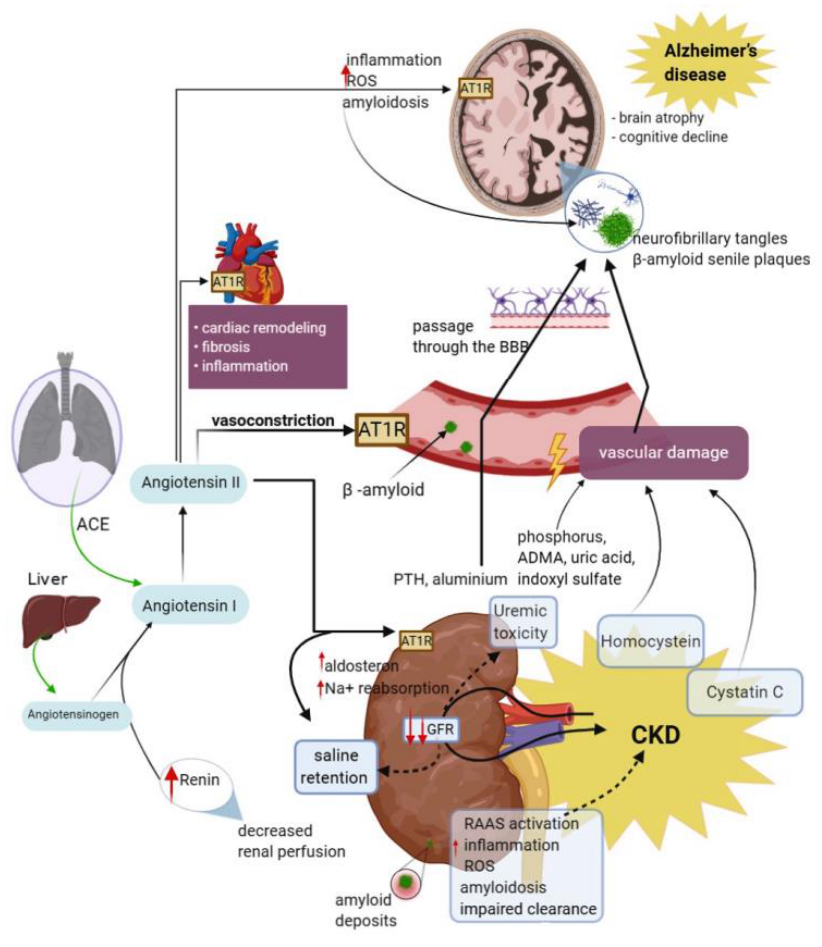
Figure 2. Schematic representation of mechanisms implicated in cognitive decline and AD in CKD patients, comprising renin–angiotensin system, oxidative stress, vascular injury, and inflammation. Diminished glomerular filtration rate and renal perfusion affect renal clearance. Renal retention of oxidizing substances promotes the intensification of oxidative stress and inflammation, which together with a defective clearance, causes an increase in plasma concentrations of uremic toxins, homocysteine, Cystatin C, amyloid deposits, and other molecules. These substances exert their toxic action through various mechanisms. Low renal perfusion leads to increased renin synthesis, and in its presence, the angiotensinogen synthesized in the liver is transformed into angiotensin I, which in turn, in the presence of angiotensin converting enzyme passes into angiotensin II. Angiotensin II activates AT1 receptors and produces hydro-saline retention, cardiac remodeling, vasoconstriction, and the development of β-amyloid deposits. The consequences of kidney damage are also reflected in the vascular and cerebral level with the aggravation of the cognitive deficit present in AD. The potential mechanisms of kidney–brain crosstalk regarding inflammatory molecules are because cytokines frequently involved in the pathogenesis of CKD may influence remote organs, such as the brain. The pathogenesis of the oxidative stress in patients with CKD is exhaustive, uremia and dialysis being among the important and frequent factors. Moreover, in these patients, an excessive increase in ROS was linked to the inflammatory processes, as the presence of endogenous oxidants and uremic toxins in the plasma may be a source of oxidative stress. Nevertheless, vascular damage and the direct neurotoxicity of uremic toxins produced by renal altered function are the most reasonable pathways of the effects of CKD in AD patients. AD, Alzheimer’s disease; ANG I, angiotensin I; ANG II, angiotensin II; ACE, angiotensin converting enzyme; RAAS, renin–angiotensin–aldosterone system; BBB, blood–brain barrier; GFR, glomerular filtration rate; AT1R, angiotensin II receptor type 1; ROS, reactive oxygen species; Na, sodium; ADMA, asymmetric dimethylarginine; CKD, chronic kidney disease.